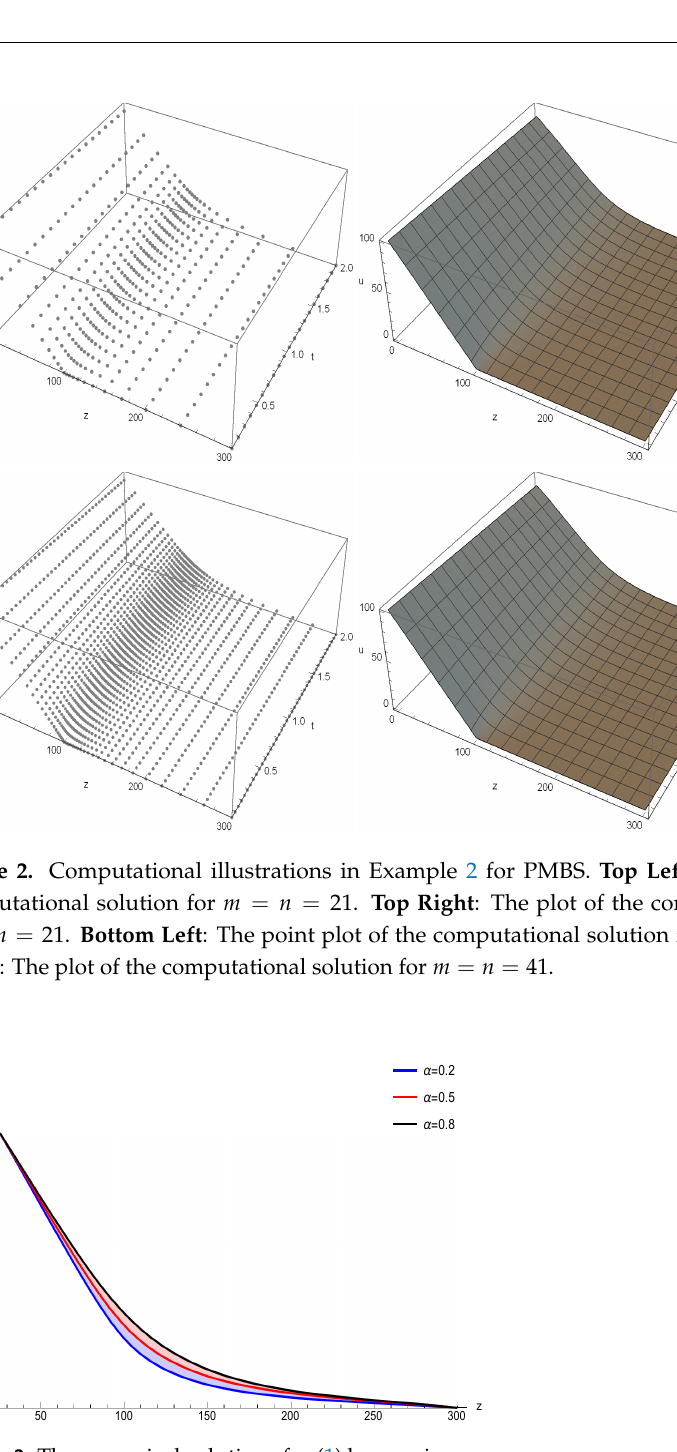
Figure 3. The numerical solutions for (1) by varying α